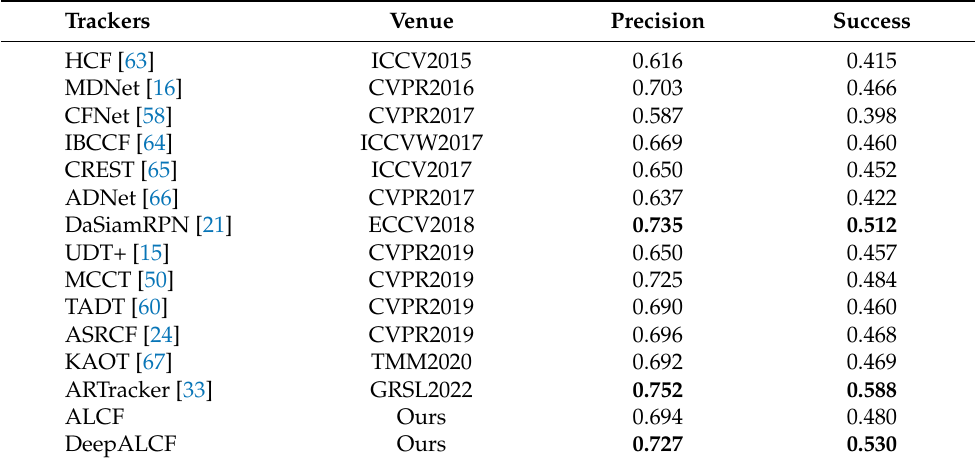
Table 5. Overall evaluation of ALCF and some other state-of-the-art trackers on DTB70 [41] (top 3 in bold ).